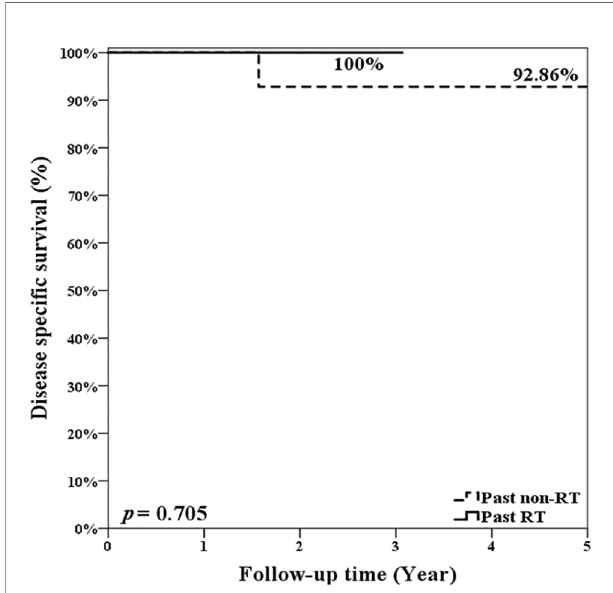
FIGURE 5 | The estimated 5-year overall survival/disease-speci fi c survival rate was 93.75%, the recurrence-free survival rate was 74.56%, and organ